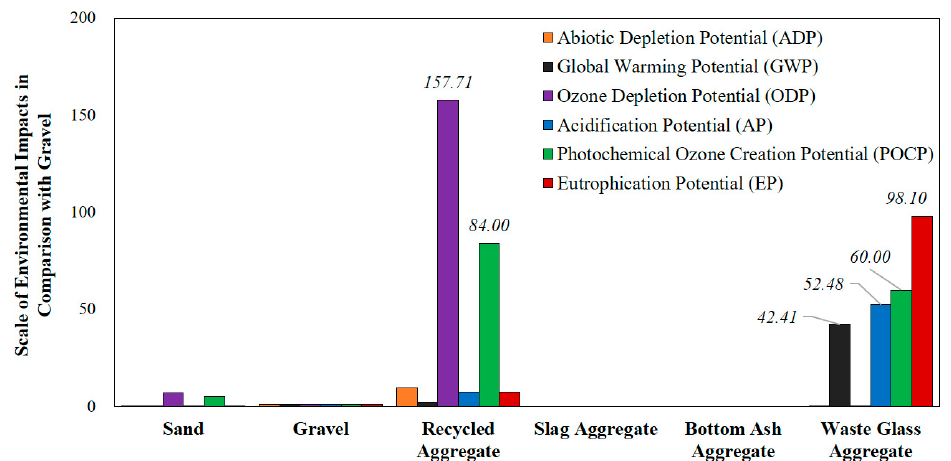
Figure 1. Scale of the Difference Between the Environmental Impact of Each Aggregate and that of Gravel.